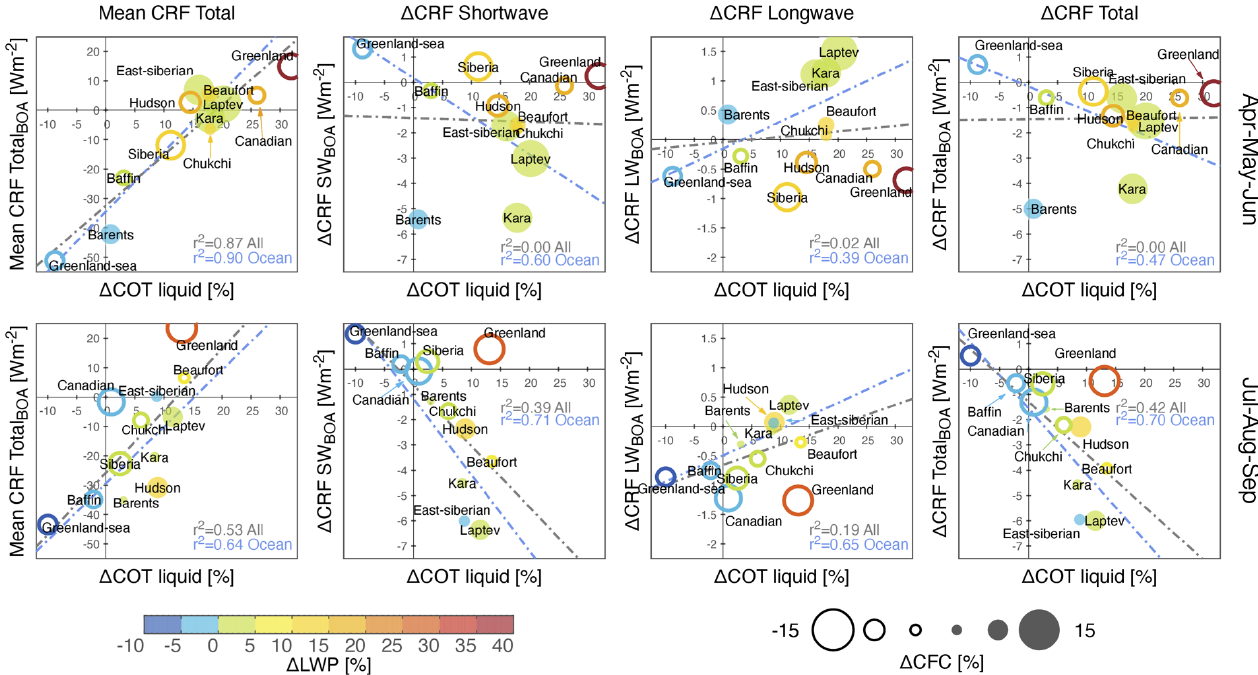
Figure 13. From left to right, regional and seasonal mean CRF, SW, LW, and total CRF trends at the surface as a function of τ trends for liquid clouds. The concurrent change in LWP is color coded while the increase (decrease) in cloudiness is given by a filled (outlined)